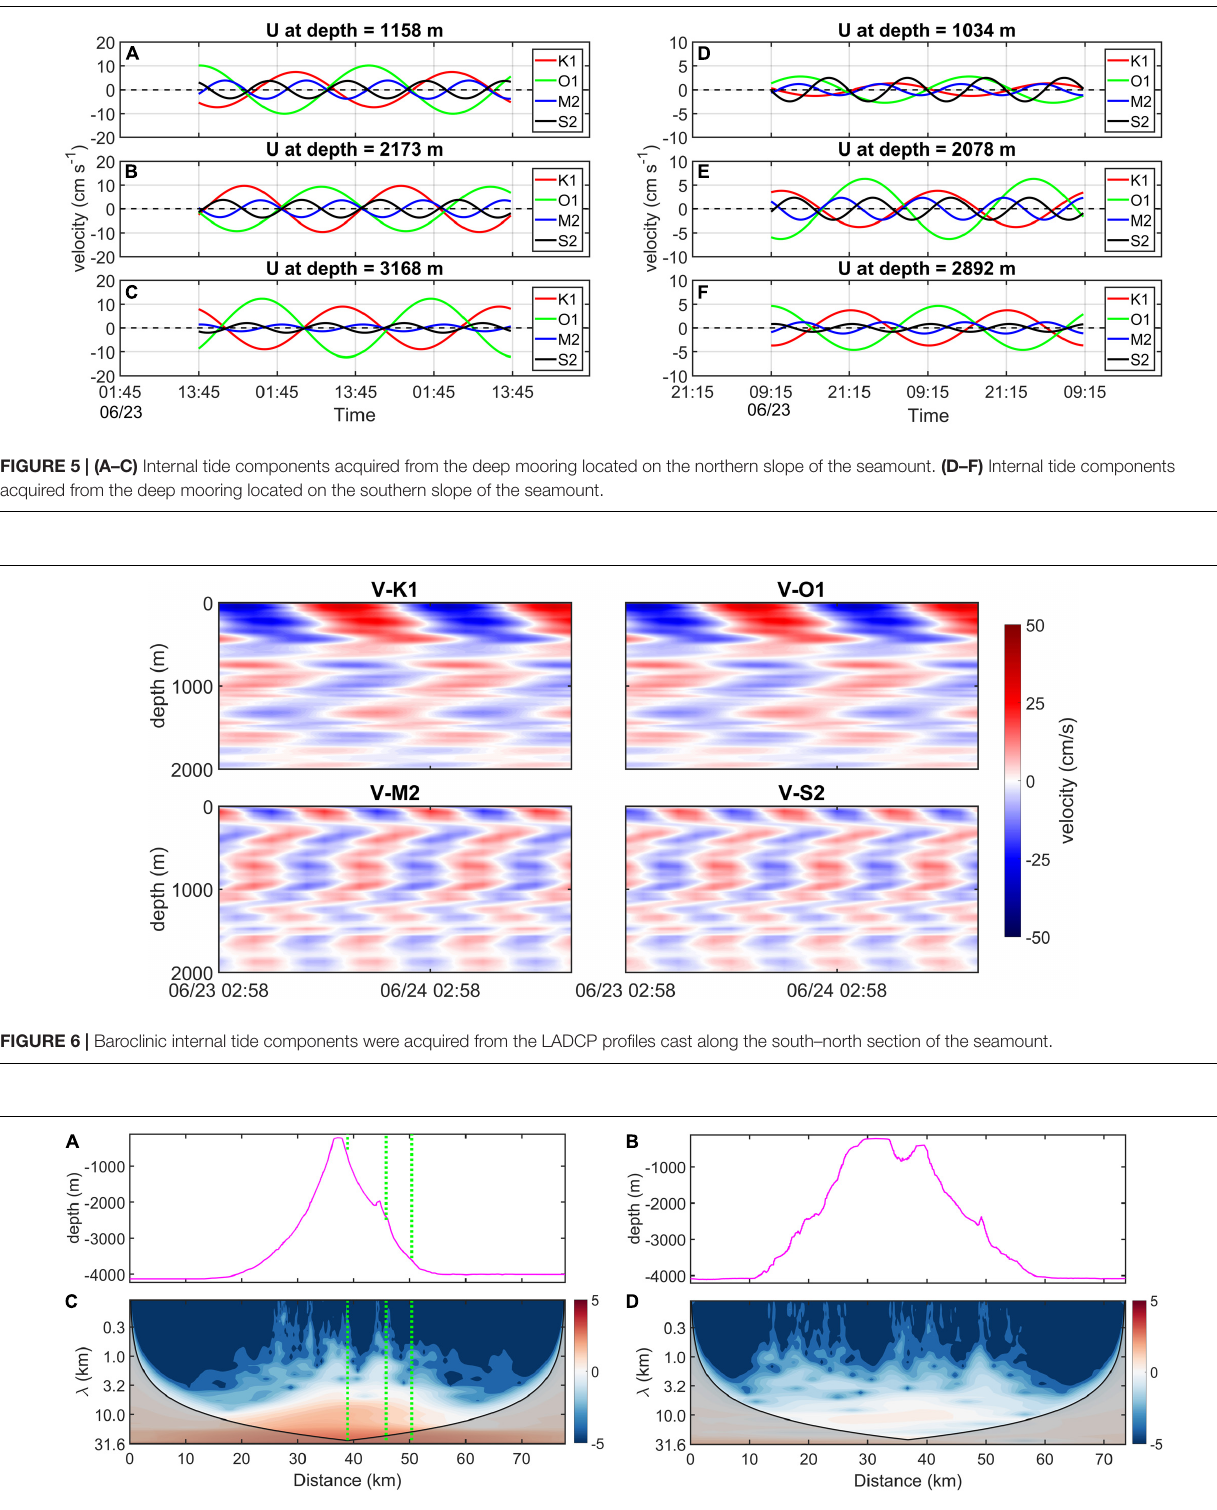
FIGURE 7 | (A,B) Topographic profiles of the meridional and zonal sections of the seamount, respectively. (C,D) Wavelet analyses of the topography of the corresponding sections. The color-filled contours are the log 10 -scaled variance (m 2 ) of the wavelet transform of the normalized topography. The black solid line in each panel indicates that the area below is subjected to the edge effect. The vertical green dotted lines indicate the positions of the VMP profiles.